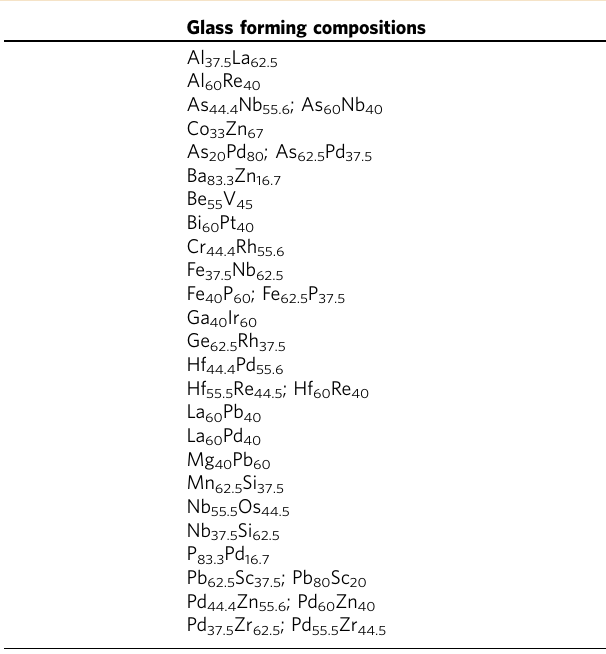
Table 2 | Potential candidate glass